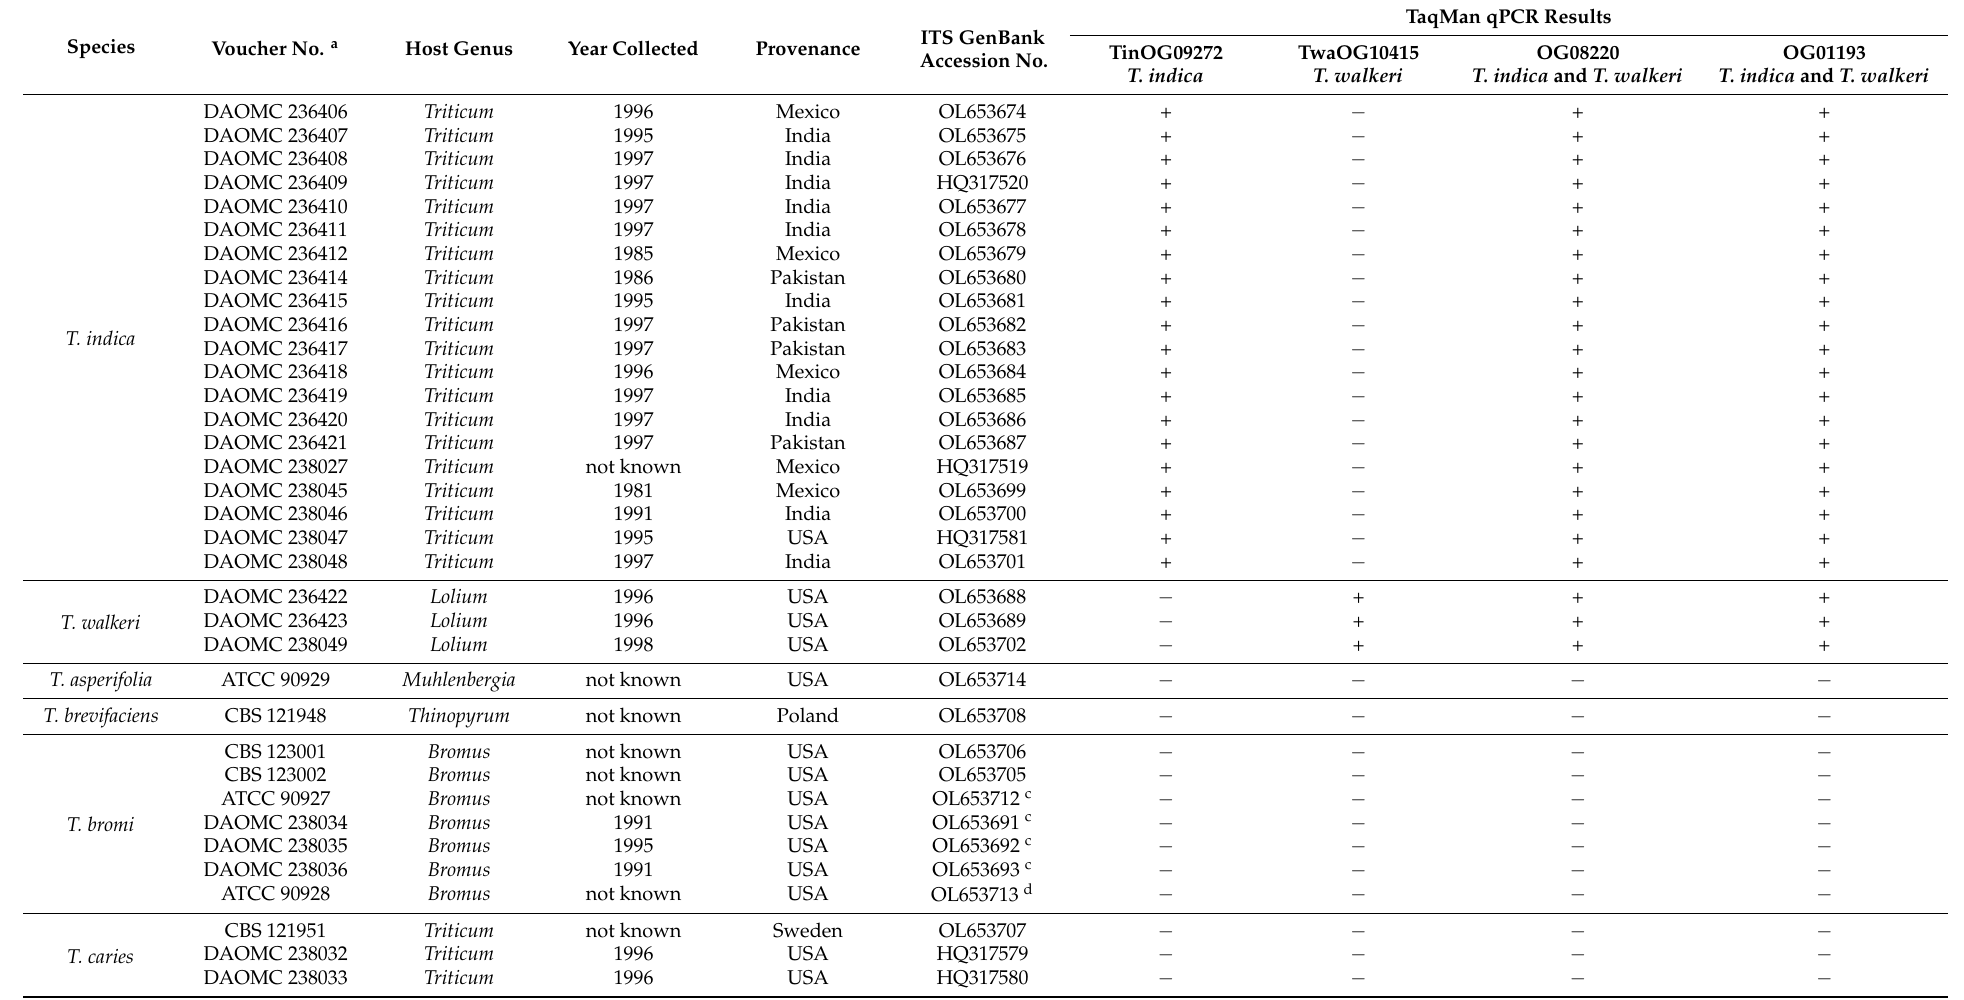
Table 2. Voucher numbers, host genus, provenance, year collected, ITS GenBank accession numbers and assay validation results for the reference Tilletia strains used in this study.